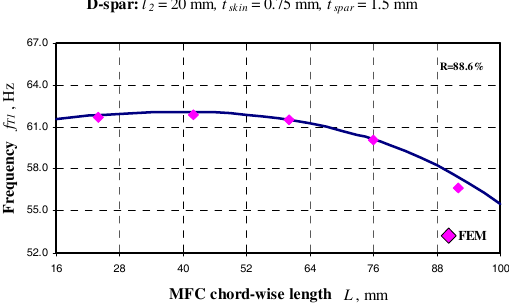
Fig 18. Finite element verification of response